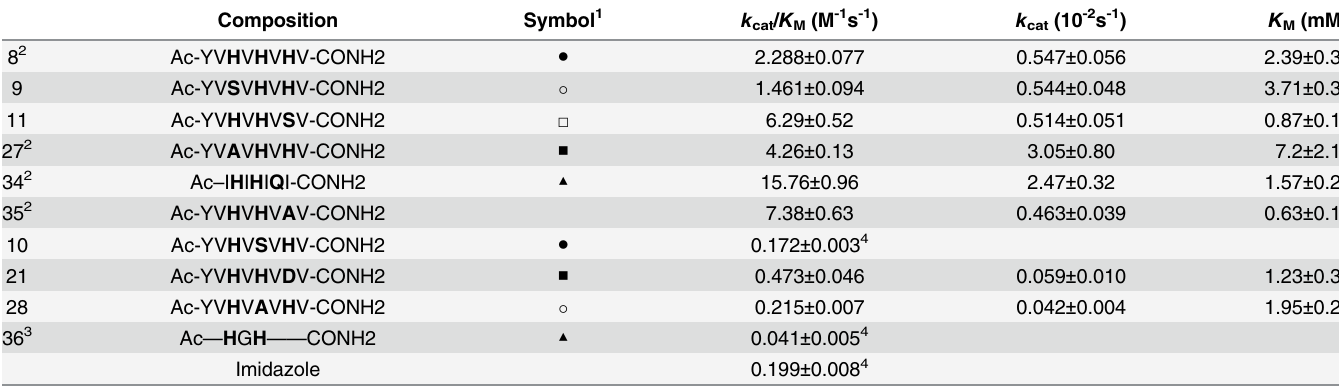
Table 3. Esterase activity of selected peptides at pH 7.3.